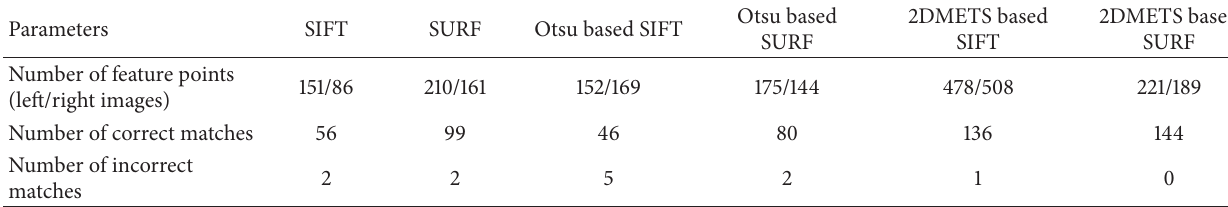
Table 2: Matching performance for images in group 2.